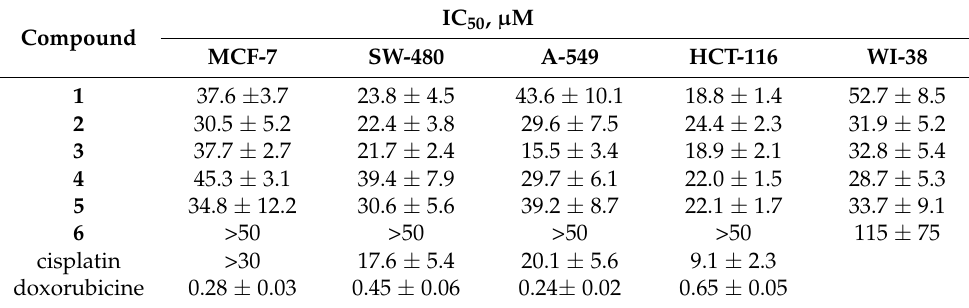
Table 4. Results of the MTT assay on different cell